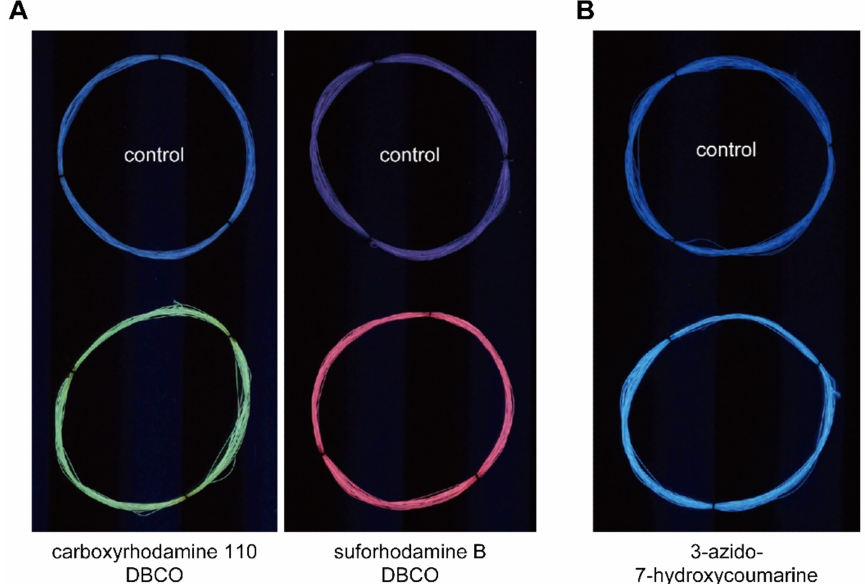
Figure 4. Preparation of differently-colored fluorescent silk fiber by modification of the azido- functionalized silk fiber with fluorescent molecules by SPAAC. The control fiber without AzPhe administration was subjected to the same reaction and washing processes. ( A ) Azido groups in silk fibroin were directly modified with DBCO-functionalized fluorescent reagents, carboxyrhodamine 110 DBCO (green) or sulforhodamine B DBCO (red). ( B ) Azido groups in silk fibroin were first converted into DBCO groups by the reaction with excess DBCO-PEG4-DBCO and then modified